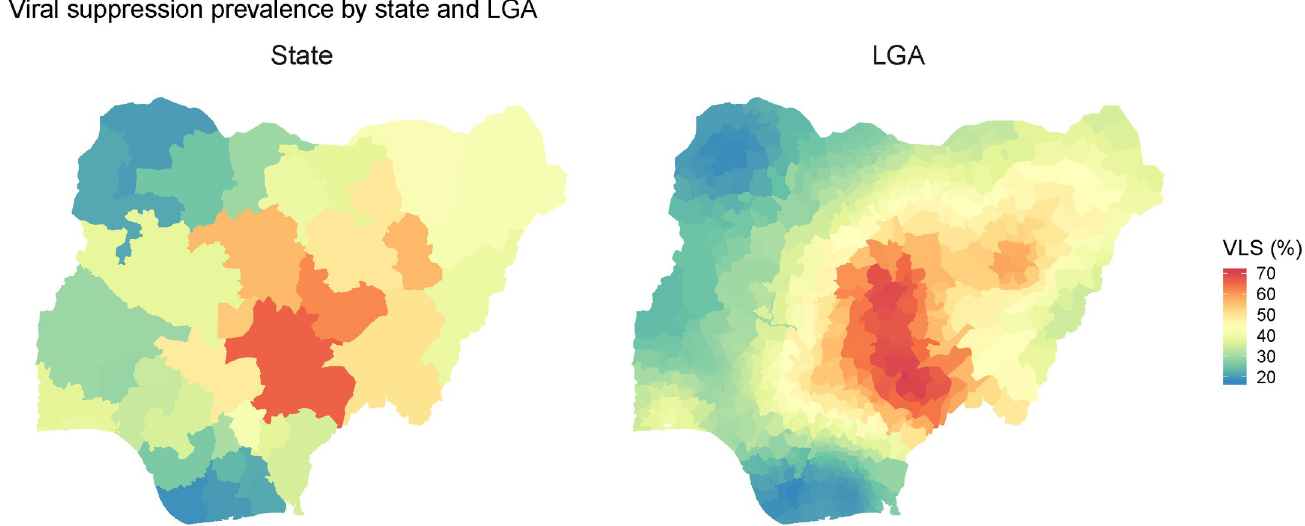
Fig 3. Estimated viral load suppression rate by state and local government area (n = 774) in Nigeria (2018).